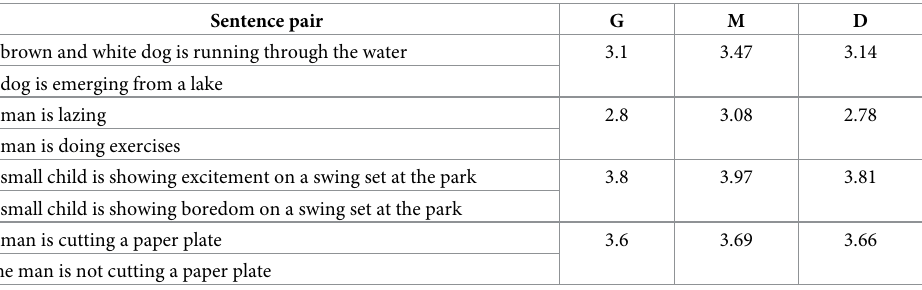
Table 4. Examples of MaLSTM and D-LSTM